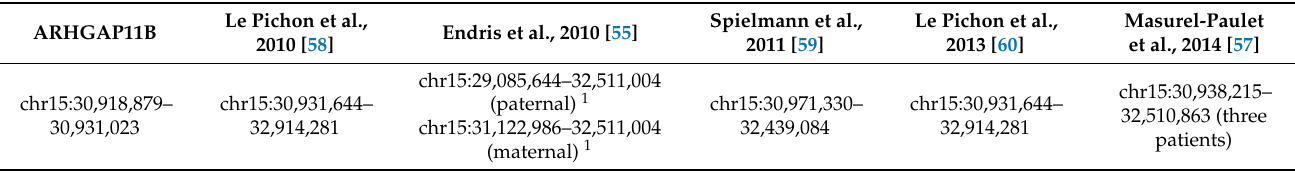
Table 2. Genomic coordinates (GRCh37/hg19 assembly) of ARHGAP11B (left) and of patients reported to have a homozy- gous 15q13.3 microdeletion (see references indicated).